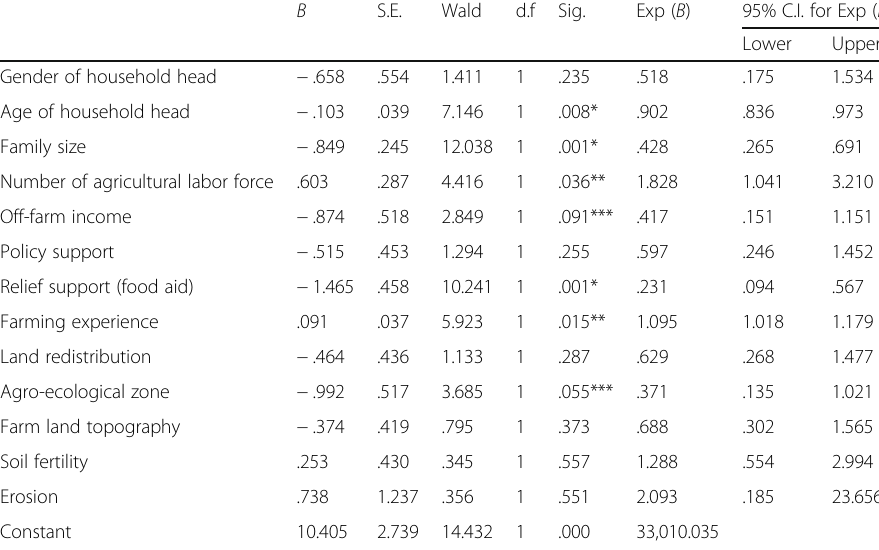
Table 6 Results of regression analysis showing determinants of food